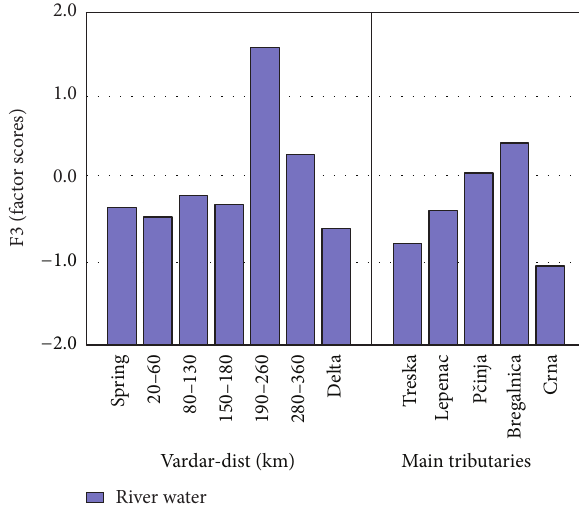
Figure 7: Concentration of P found in river Vardar and main tributaries.